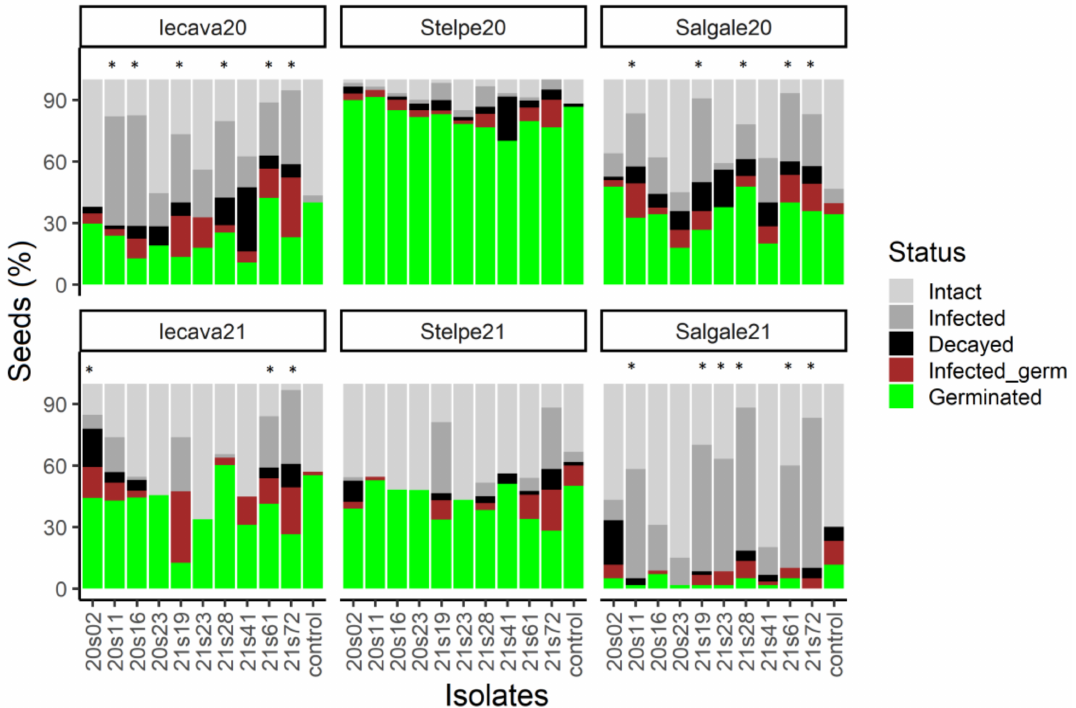
Figure 4. Seed fate after inoculating surface-sterilized seeds with spore suspension of different Fusarium isolates and subsequent incubation at 10 ◦ C for 14 days and at room temperature for 28 days. Non-inoculated seeds were used as a control. Seeds collected in different years and from different plant populations are shown separately. Asterisk (*) denotes treatments where the number of intact seeds at the end of experiment was significantly different from the control